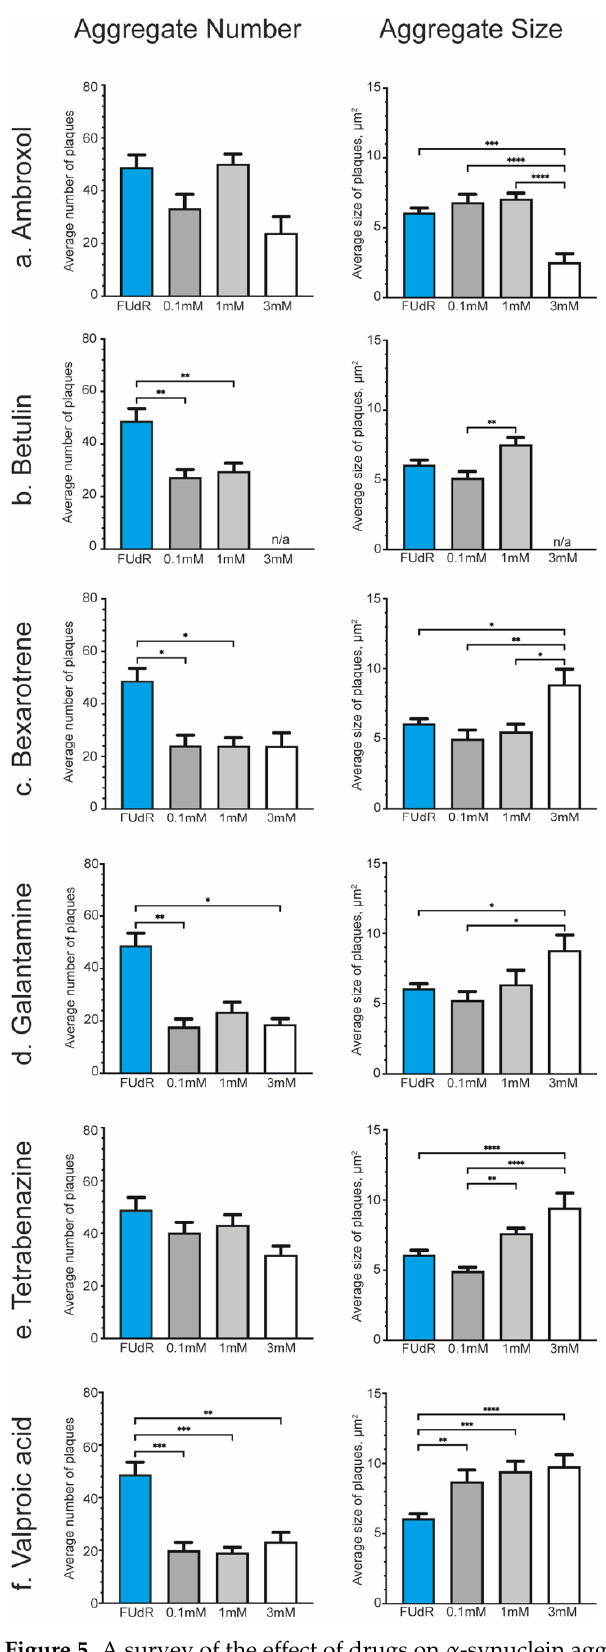
Figure 5. A survey of the effect of drugs on α -synuclein aggregates. Quantification of the number ( left panel) and size ( right panel) of α -synuclein aggregates from Zeiss images after exposure to drugs for 1 week (L4 + 7 days) for each drug. In all cases, the average is plotted with the standard error of the mean (s.e.m.). The statistical tests are a one-way ANOVA where * p < 0.05, ** p < 0.01, ***